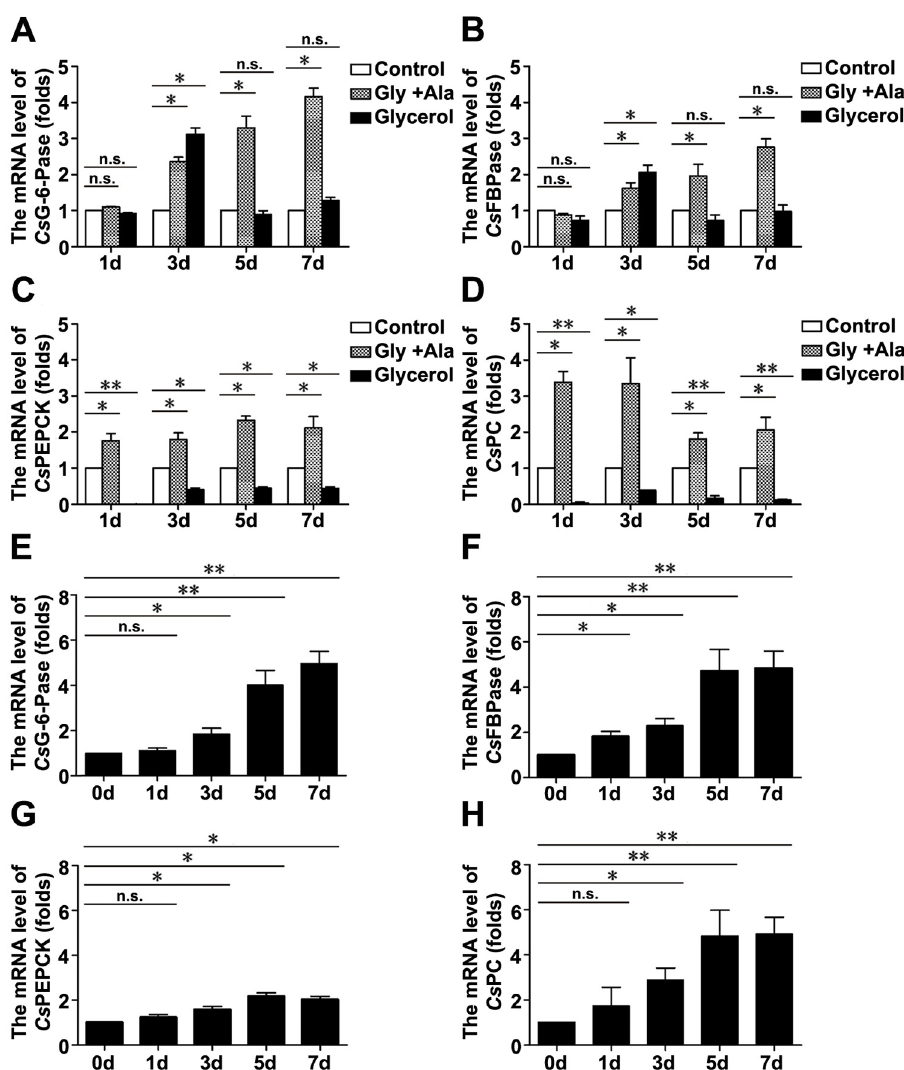
Fig 2. The mRNA levels of Cs G-6-Pase, Cs FBPase, Cs PEPCK, and Cs PC in 1 × Locke’s with or without the addition of different nutrients. The mRNA levels of Cs G-6-Pase (A), Cs FBPase (B), Cs PEPCK (C), and Cs PC (D). Time course of Cs G-6-Pase (E), Cs FBPase (F), Cs PEPCK (G), and Cs PC (H) mRNA levels in Gly + Ala. ANOVA was used to analyze the comparisons. � P < 0.05 and �� P < 0.01 versus control (A-D) or 0 d (E-H); n.s., not significant.